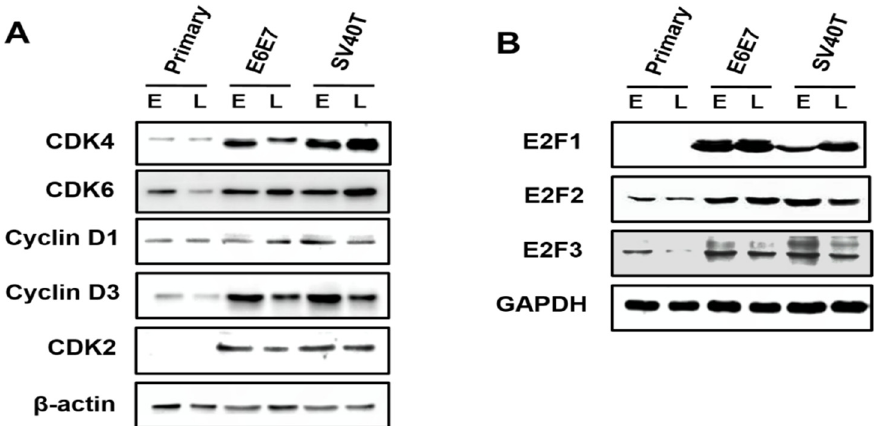
Figure 3. Involvement of E2F signaling pathway in the proliferation of the immortalized BMECs. ( A ) Western blotting analysis of CDK4, CDK6, cyclin D1, cyclin D3, and CDK2 in primary and immortalized BMECs. ( B ) Western blotting analysis of E2F1, E2F2, and E2F3 in primary and immortalized BMECs. Primary BMECs or BMECs immortalized by E6E7 and SV40T were collected at early (E) and late (L) passages of culture. Data are based on triplicate experiments.